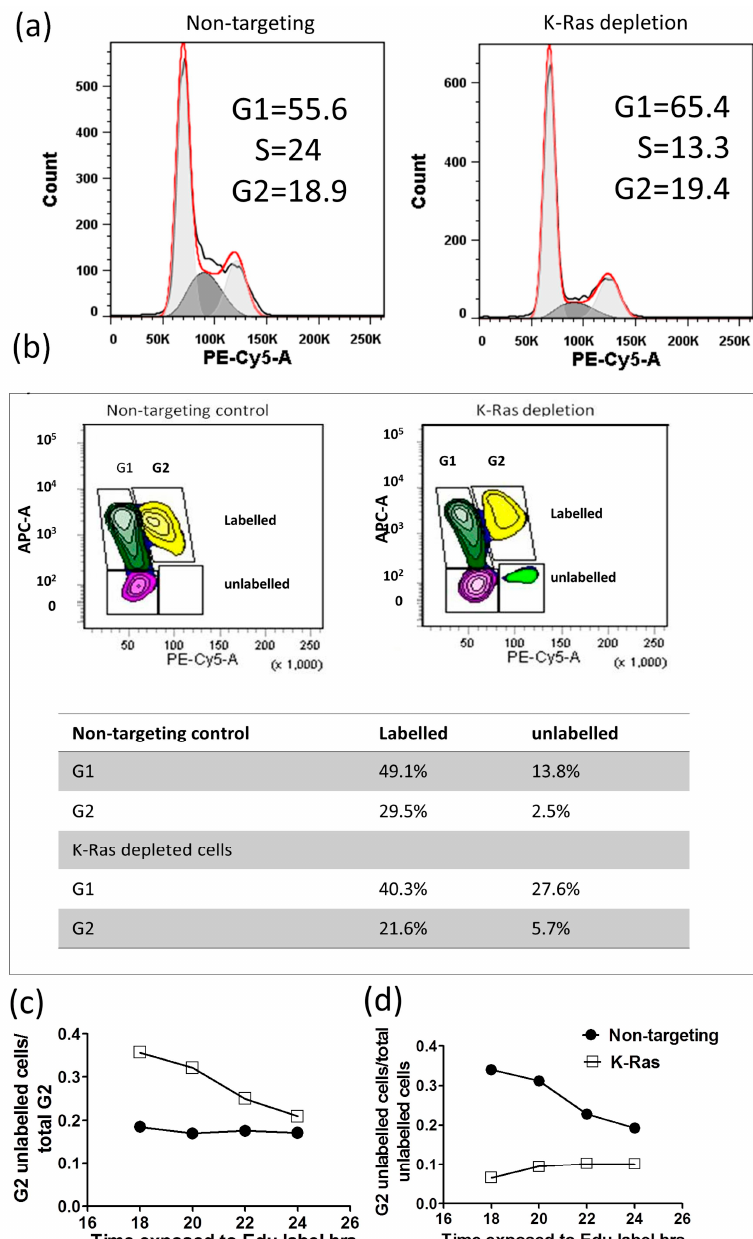
Figure 3. Cell cycle analysis following K-Ras depletion: ( a ) FACS analysis of the cell cycle using PI staining showing reduced S-phase but little change in G2 level. ( b ) An example of Edu analysis of